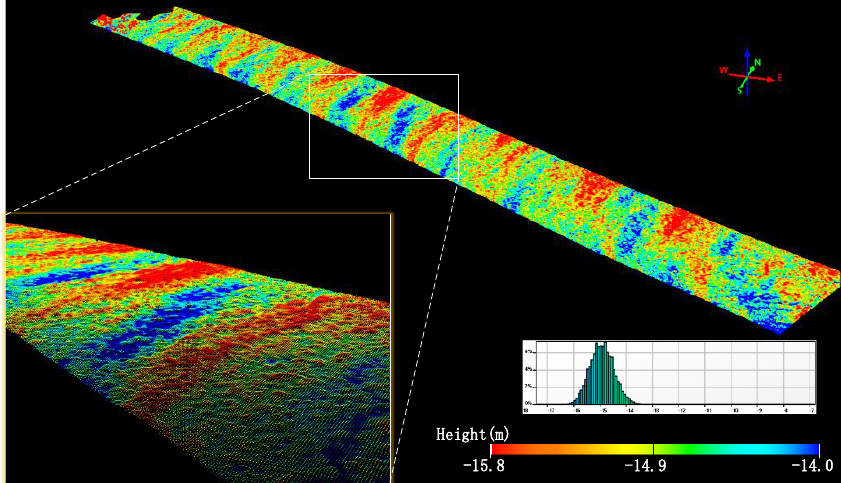
Figure 1. Water surface undulations represented by ALB point cloud.